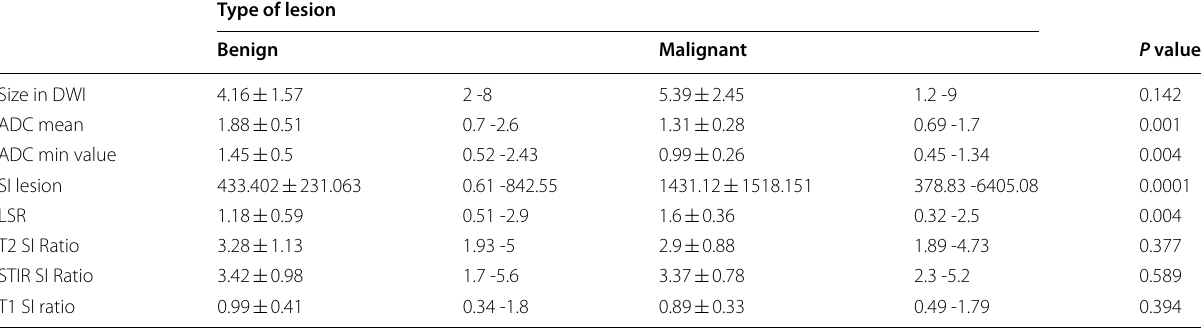
Table 2 Comparison of DWI‑MRI parameters according to type of lesion Type of lesion Benign Malignant P value Size in